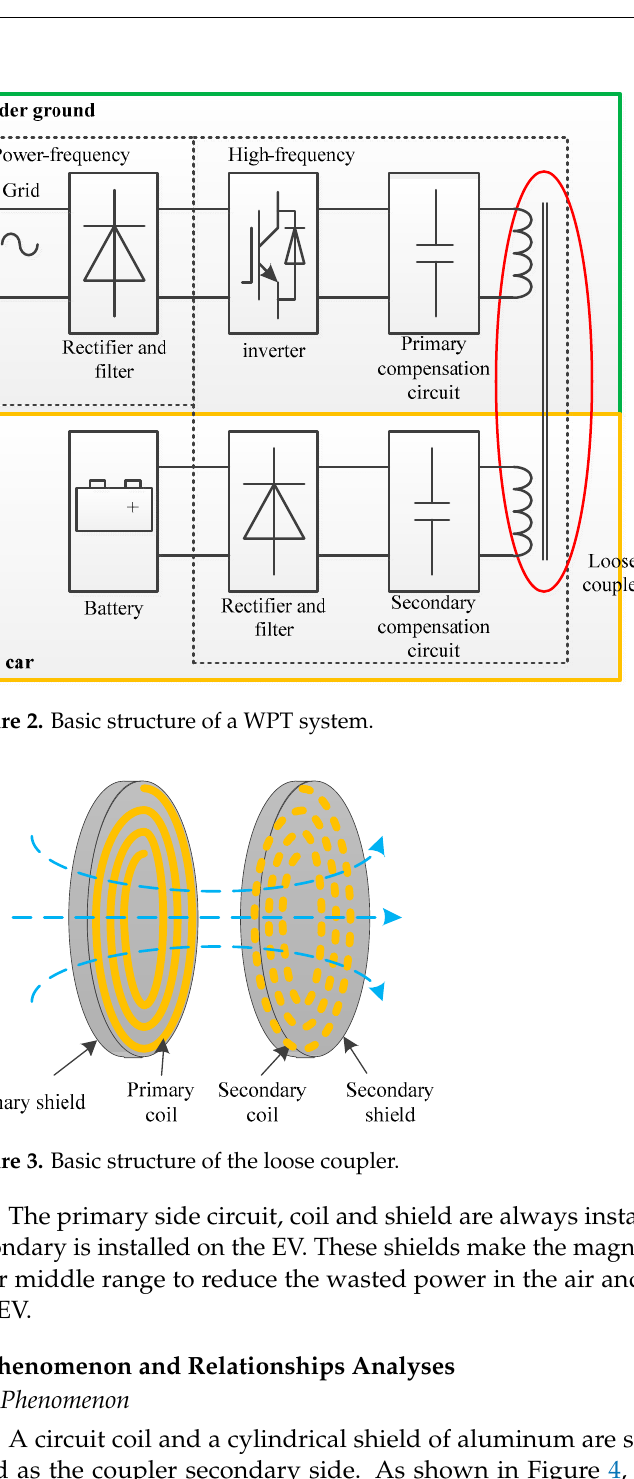
Figure 5. Magnetic field lines of shield of ferrite. In order to clearly observe the magnetic field distributions by the soft and hard magnetic materials, distribution diagrams and curves of magnet field strength by alu- minum and ferrite are shown in Figures 6 and 7, respectively, by the finite element analysis. They show that due to the influence of the fringe effect, the magnet field is gathered at the edge of the shield of the ferrite because it is a kind of soft magnetic mate- rial, and its magnet field strength obviously increases at the edge compared with the aluminum. This phenomenon results in the longer length of the closed magnet field lines. More energies are used to generate magnetic field to transfer power. ( a ) ( b ) Figure 6. Distribution diagrams of magnetic field strength for different materials. ( a ) Aluminum. ( b ) Ferrite.